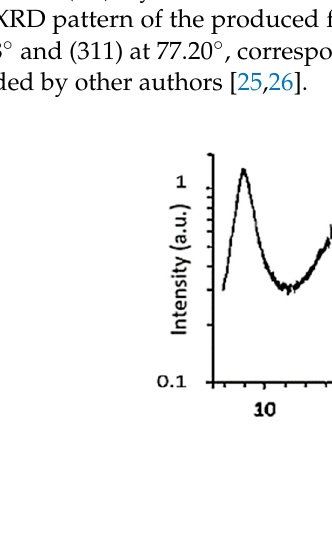
Figure 6. X-ray diffraction patterns: full pattern of silver-enriched gelatin–beetroot nanocomposite films ( a ) and pattern of gelatin ( b ).